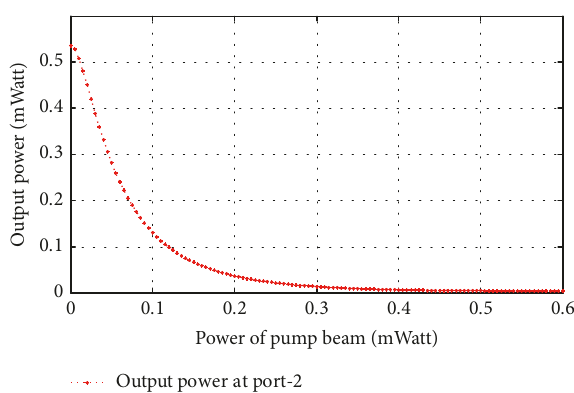
Figure 6: Variation of the output power at port 2 with respect to input pump